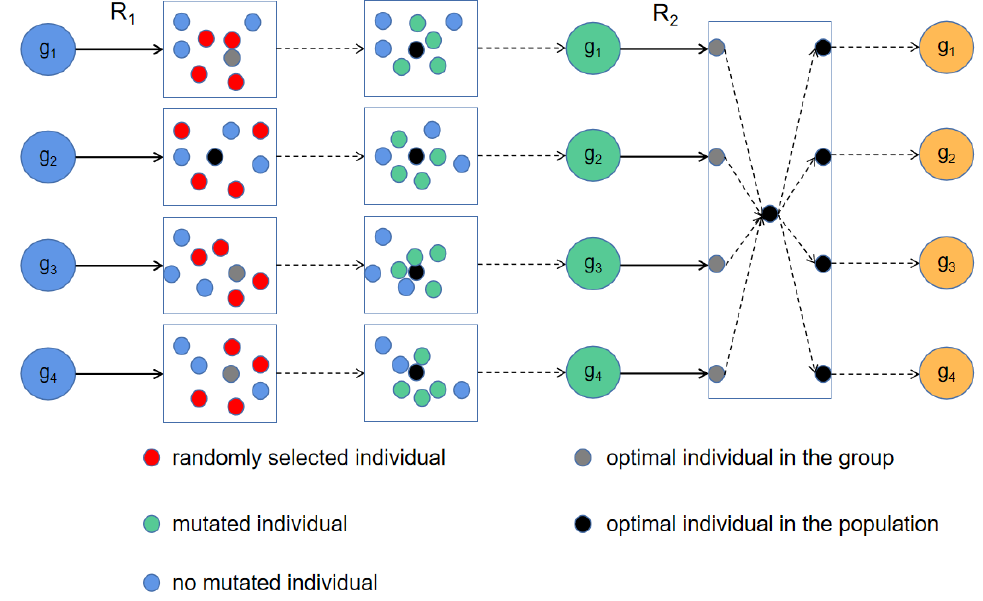
Figure 4. The running process of the population competition communication